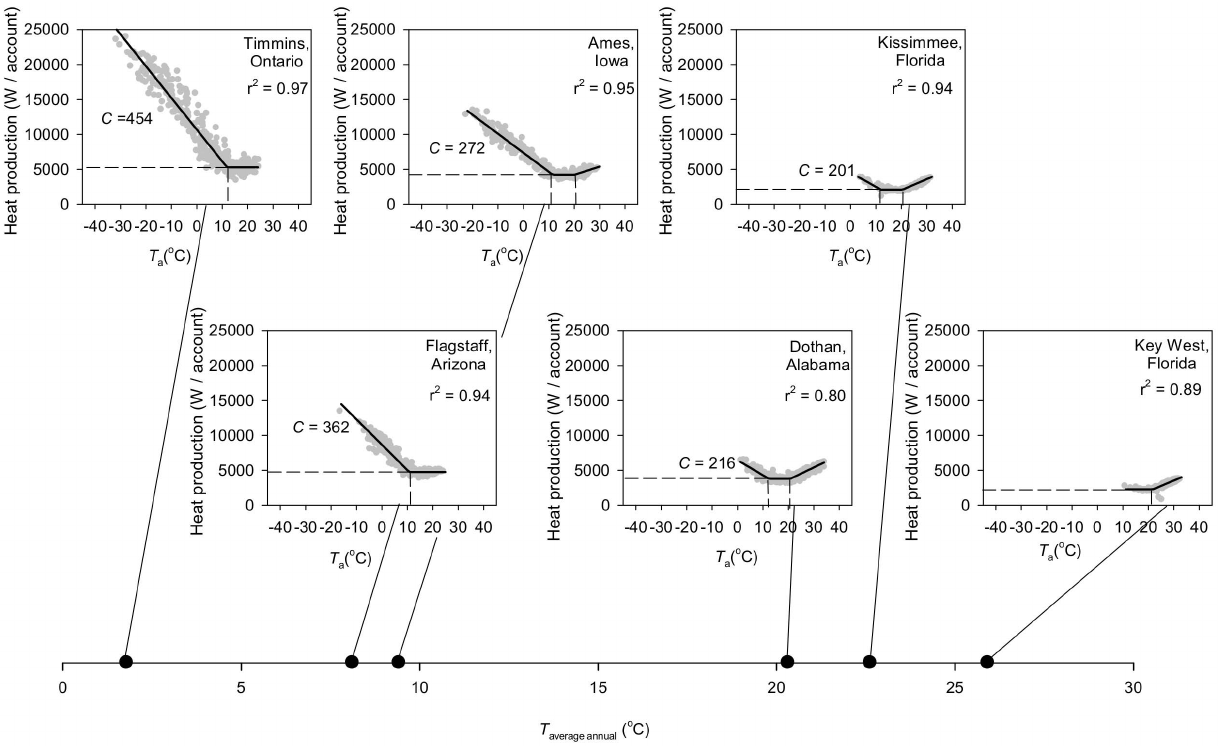
Figure 2. Rate of energy use as a function of ambient temperature ( T a ) in six North American cities. Each plot covers 365 days, with each symbol representing one day. The rate of heat production each day is expressed per utility account (i.e., per separately billed house or other living unit), and T a is the daily average (Table S1) for the same day. T average annual is the average T a for all days included in the annual dataset. Lines between individual city T a axes and the T average annual axis connect equal temperatures. Vertical and horizontal dashed lines are as in Fig. 1A. C is the absolute value of the slope at T a , T LC (see Fig.